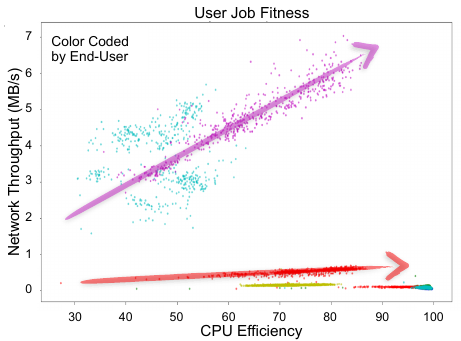
Figure 4. Relation between network throughput and CPU e ffi ciency: Given jobs of the same workflow, too little available network throughput reliably coincides with low CPU e ffi ciency. Notably, there is no general correlation between CPU e ffi ciency and network throughput – other factors may reduce CPU e ffi ciency as well. However, limited network reliably creates a limit for the maximum CPU e ffi ciency